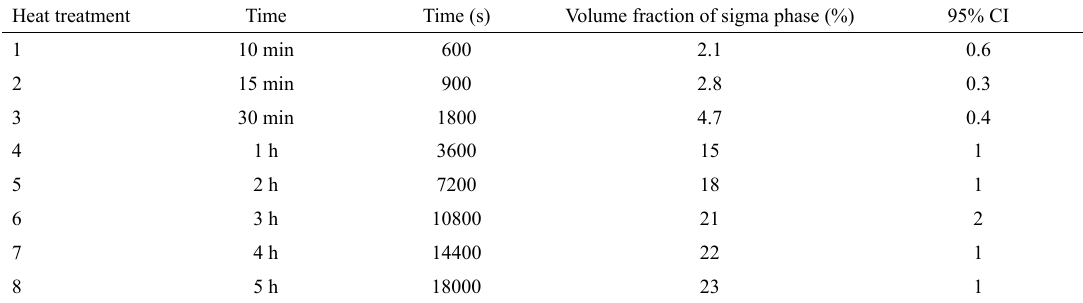
Table 3. Volume fractions of intermetallic phase obtained from Image J analysis. Heat treatment